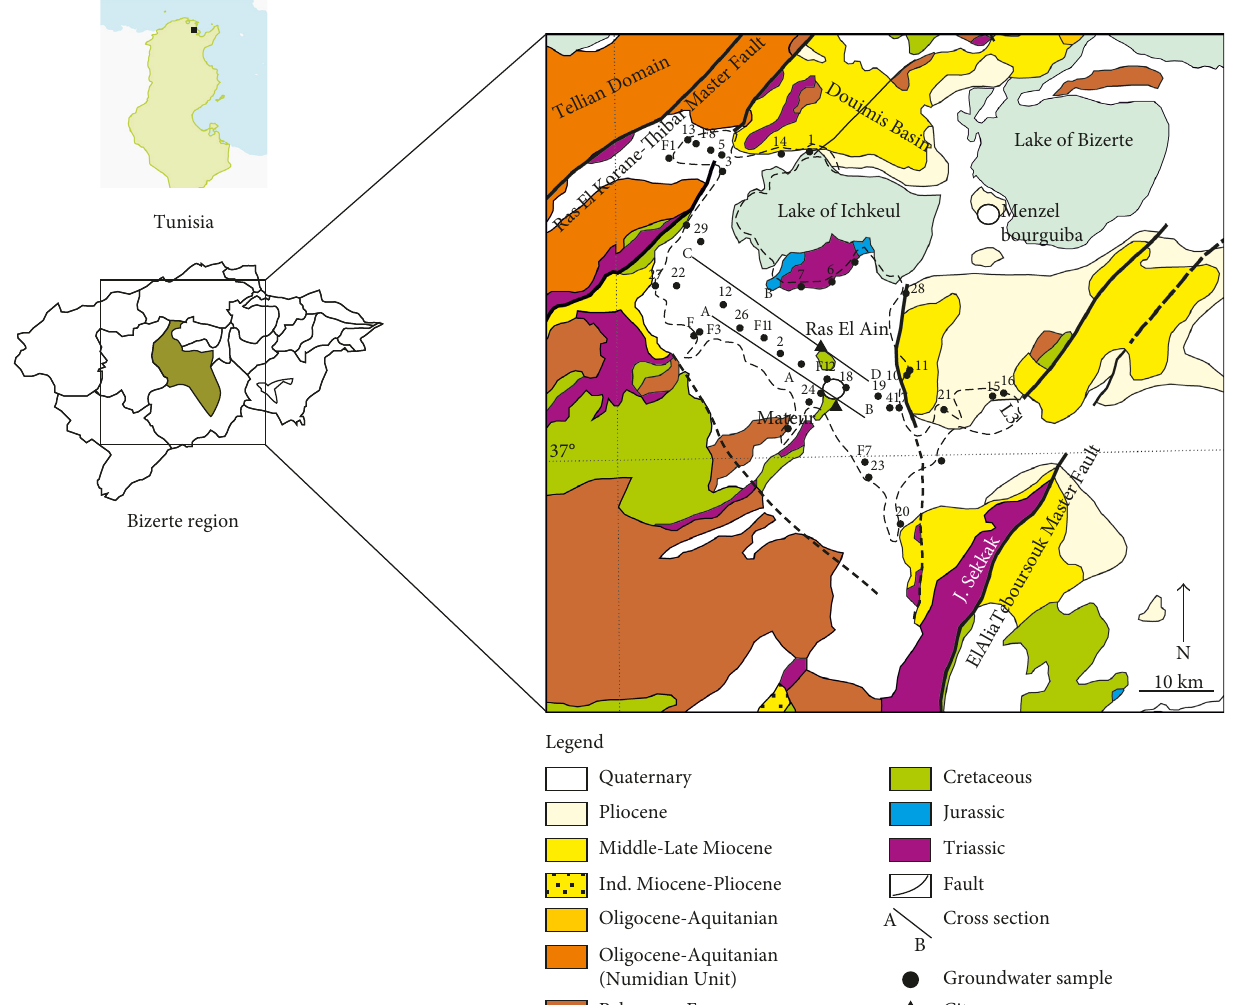
Figure 1: Location, geology [14], and sampling points of the study area.